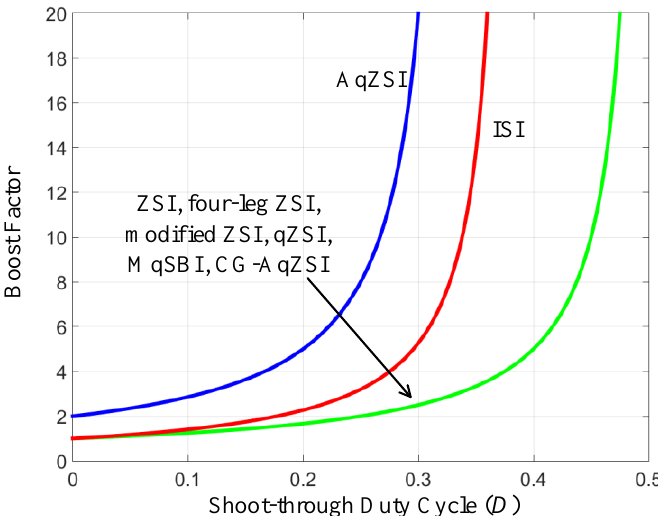
Figure 11. Comparison of boost factor.